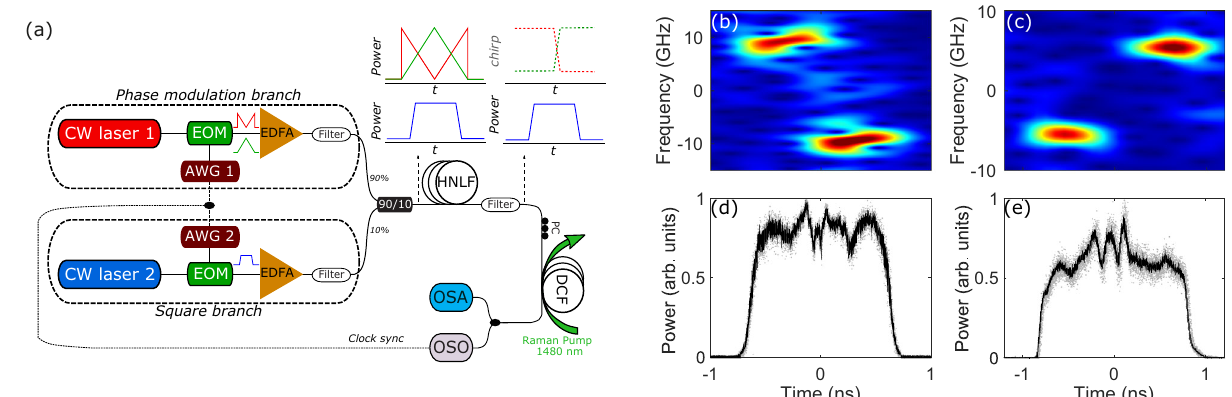
Fig. 4 Sketch of the experimental setup and characterization of the initial condition. a EOM electro-optic modulator, EDFA erbium-doped fi ber ampli fi er, AWG Arbitrary wave generator, OSO optical sampling oscilloscope, OSA Optical Spectrum Analyser, HNLF highly nonlinear fi ber, L H = 500 m, DCF dispersion compensating fi ber, L = 15 km, PC polarization controller. The choice of intensity modulation (M- or triangularly-shaped sketched in red and green, respectively) in the upper block (Phase modulation branch) is transformed into a stepwise chirp (either descending or ascending) of the beam at λ 2 , which is also intensity modulated to produce square pulses in the bottom block named Square branch, to compose the input of the DCF. b – e Experimental characterization of the input to the DCF: ( b , c ) spectrograms Δ f vs. time T (dark red and blue stands for the maximum and minimum power density, respectively); ( d , e ) Power pro fi le of the frequency modulated rectangular pulse. Left column ( b , d ) and right column ( c , e ) refer to the case of descending and ascending step-like frequency variation mimicking a pushing or retracting pair of pistons, respectively.